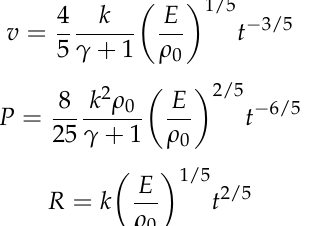
Figure 15. Particle observation caused by laser irradiation when pulse number is ( a ) 110, ( b ) 500, ( c ) and 1000. If the pressure of the laser shockwave induced by a high-intensity focused laser beam is larger than the adhesion force of the particles to the glass substrate, the particles may become detached. The shockwave velocity, pressure, and radius were calculated from Equations (1)–(3).